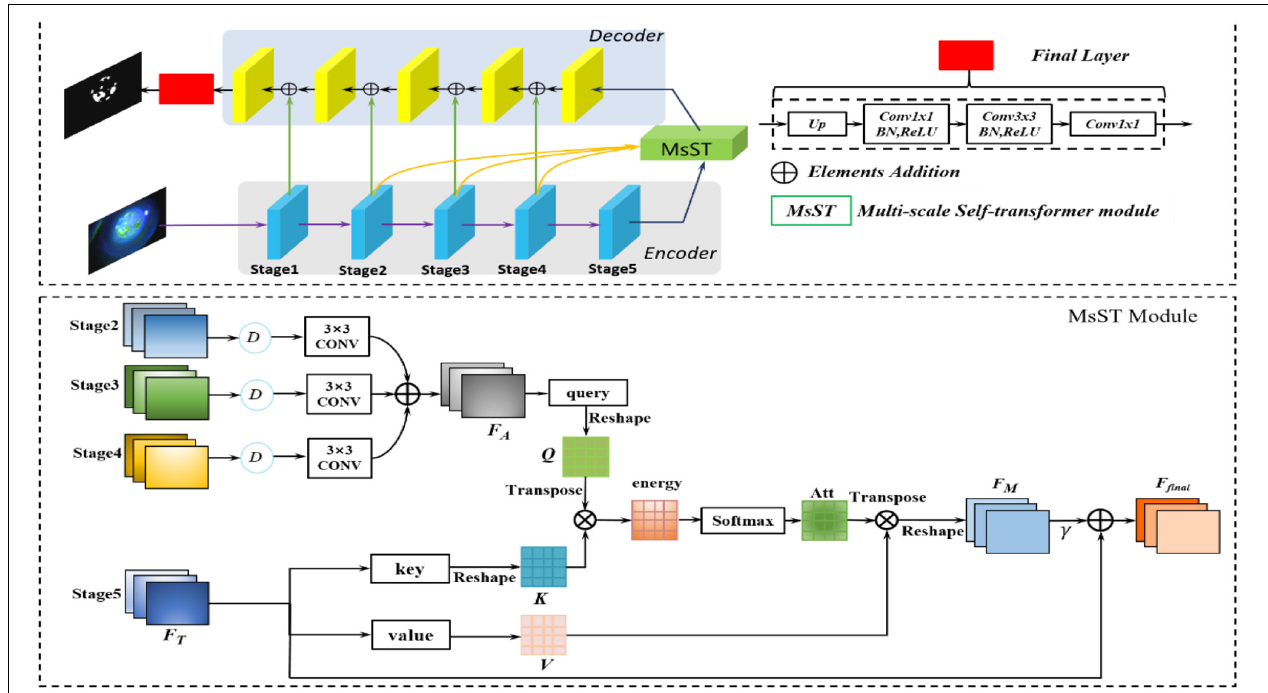
FIGURE 3 | Overview of the proposed multi-scale self-transformer network (MsSTNet). The original image is fed into the encoder path composed of a pre-trained ResNet-18 to obtain the high-level features. Then, the feature maps from stages 2, 3, 4, 5 are fed into the MsST module to fuse multi-scale and multi-semantic information. Subsequently, the features are recovered by the decoder path. Finally, the predicted images are obtained.